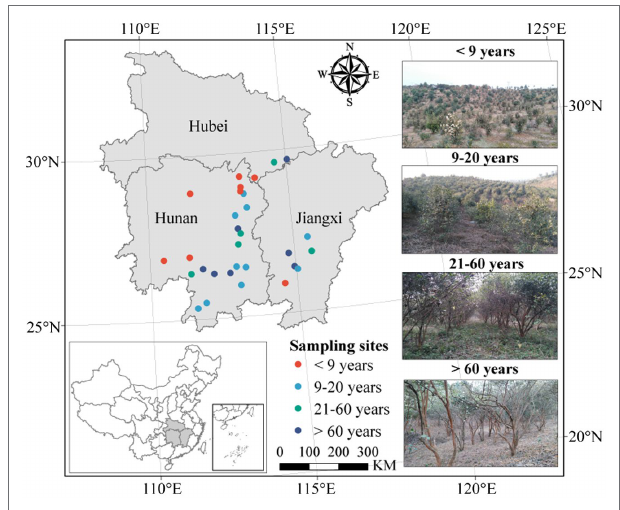
FIGURE 1 | Geographical locations of the sampling